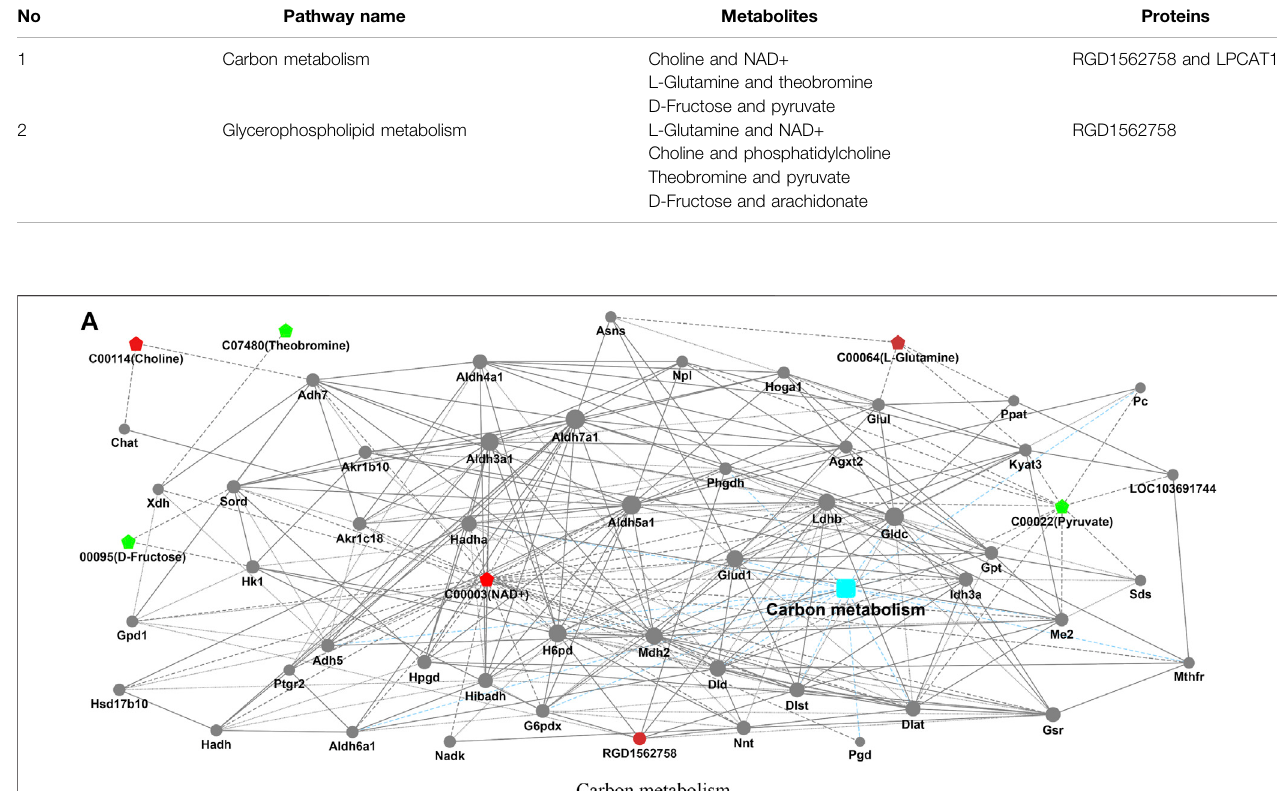
Frontiers in Physiology |